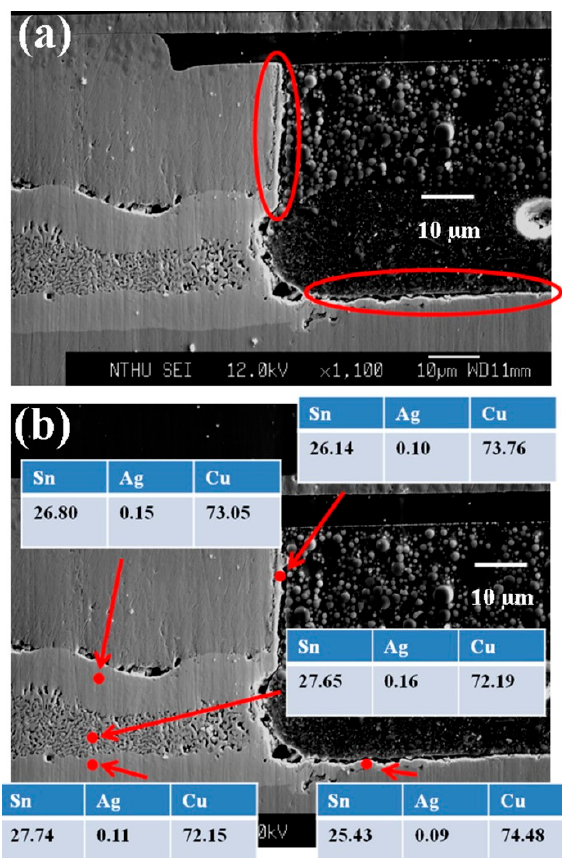
Figure 6. Cross-sectional SEM images of ( a ) IMCs formed on the side wall and ( b ) EPMA analysis. The composition data were shown in atomic percent.